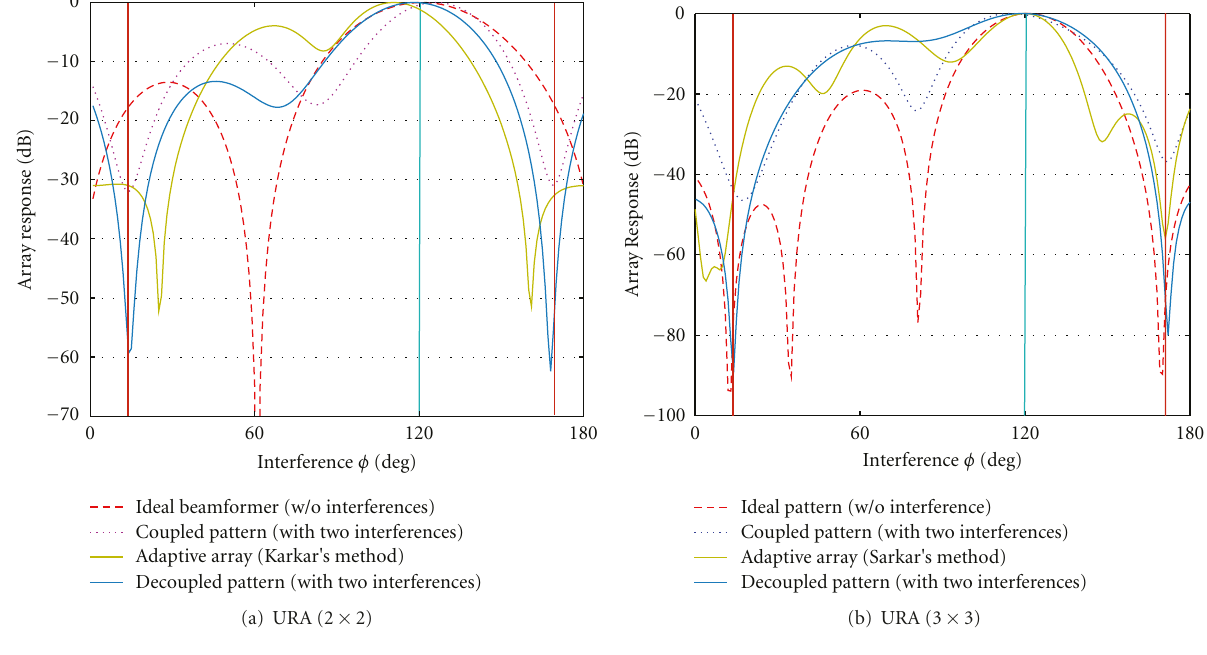
Figure 1: The beam pattern in di ff erent scenarios for ISR = 50dB Table 1: Parameters setup of test scenarios.